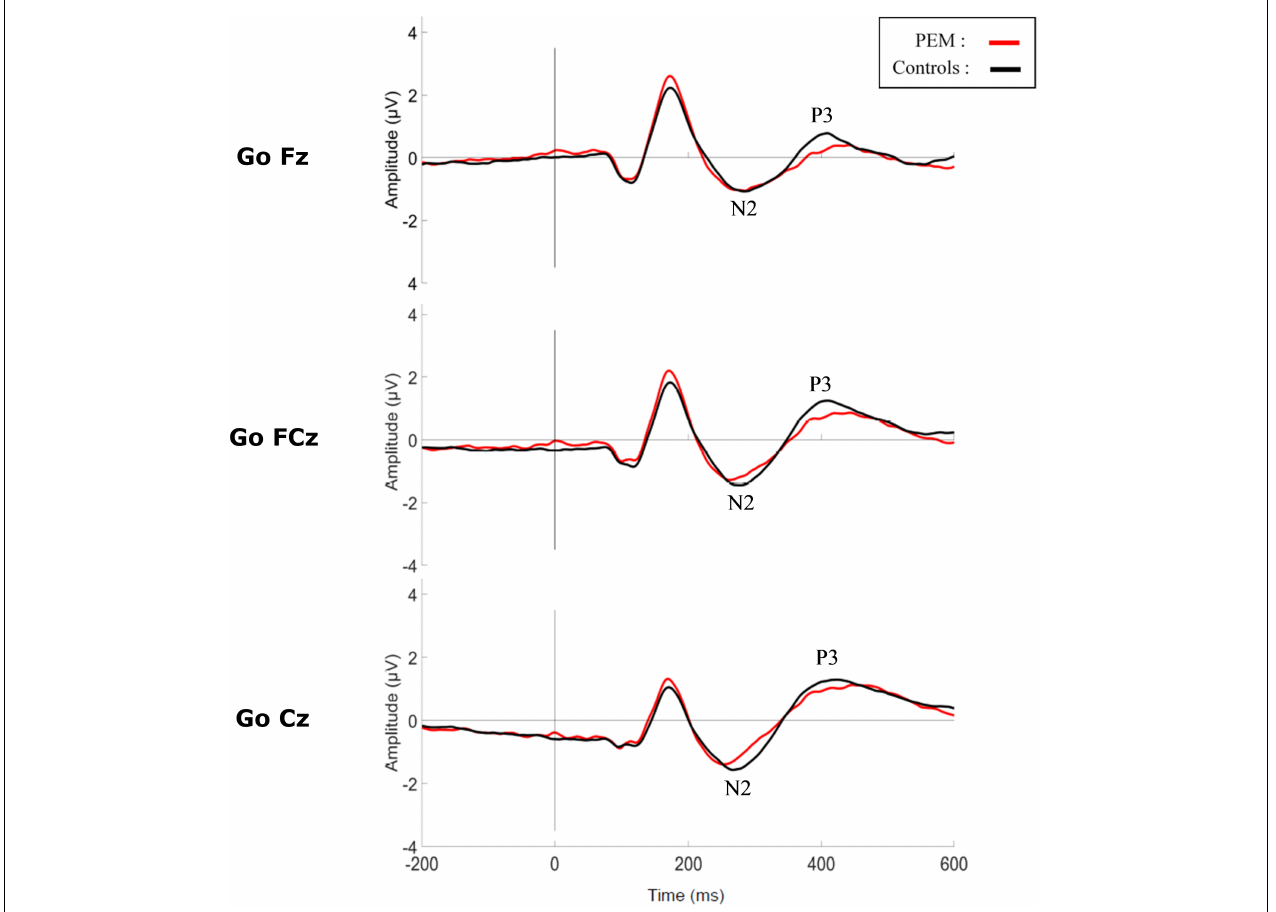
FIGURE 4 | Grand average waveform of the N2 and P3 components during Go condition for each group.